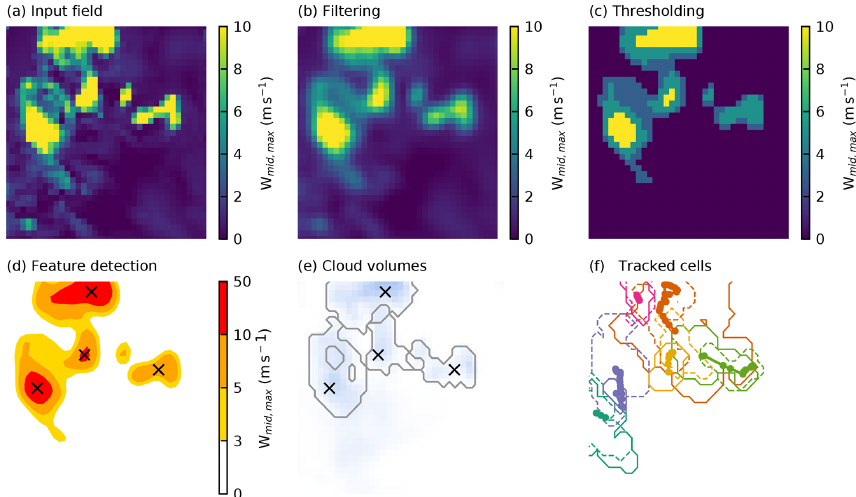
Figure 4. Schematic overview of the individual steps of the tracking algorithm for an example subset of the domain used in example A including the input mid-tropospheric velocity field. The input data (a) are smoothed with a filter (b) before regions above or below a set of thresholds are determined (c) to identify the individual features (d) . (e) The surface projection of the associated cloud volumes determined in the segmentation set and (f) the entire trajectories of the cells present at this time step, including the surface projection of the cell volume at the start (dashed) and at the end (solid) of the